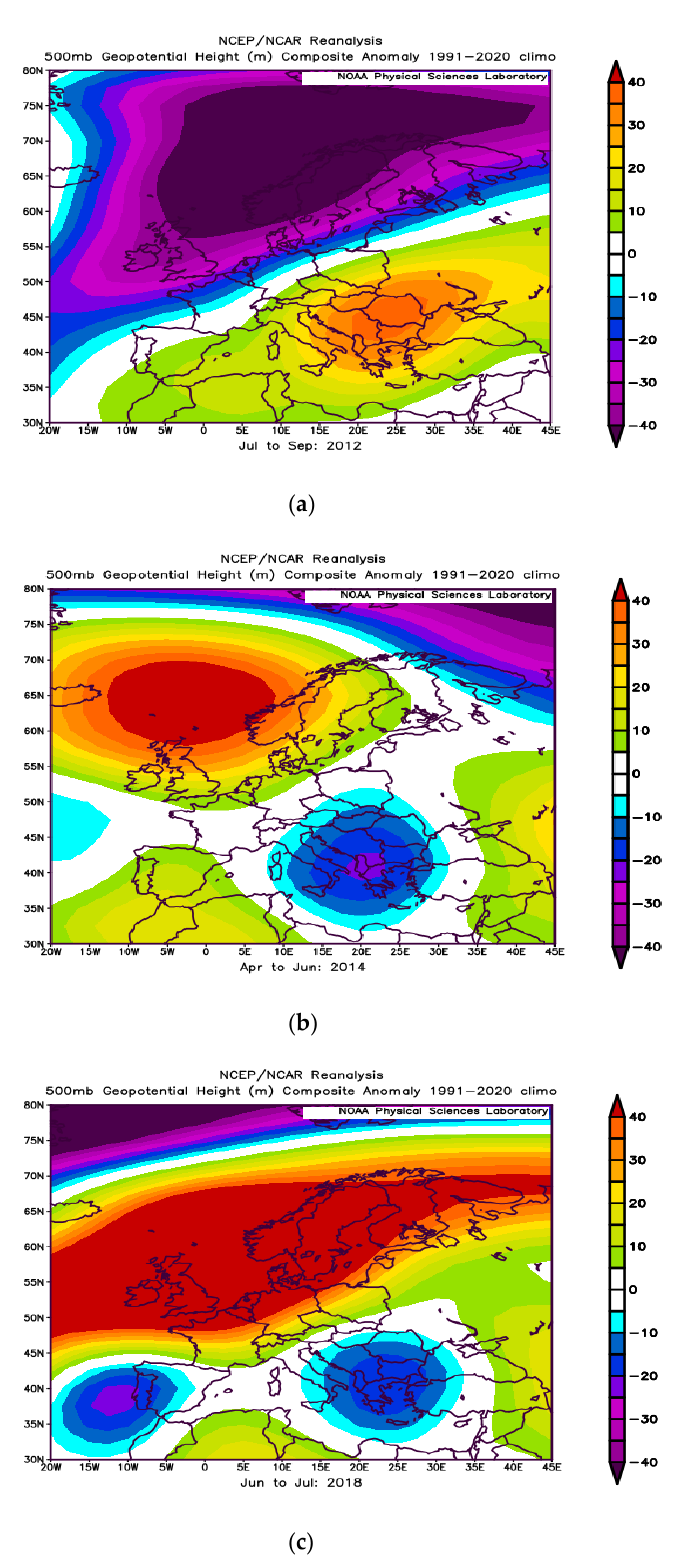
Figure 6. ( a ). Composite geopotential height at 500 hPa isobaric surface—anomaly for July–September 2012. Images provided by the NOAA/ESRL Physical Sciences Division, Boulder, Colorado, from their Web site at http://www.esrl.noaa.gov/psd (accessed on 15 October 2022) [18]. ( b ).